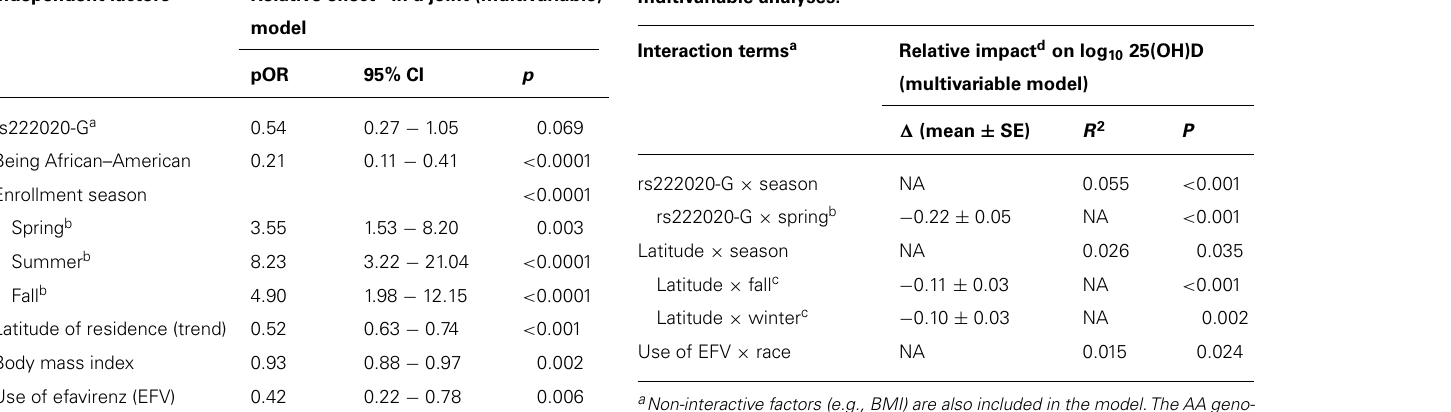
Table 4 | Independent predictors of serum 25(OH)D concentration as three ordinal categories (deficiency, insufficiency, and sufficiency).